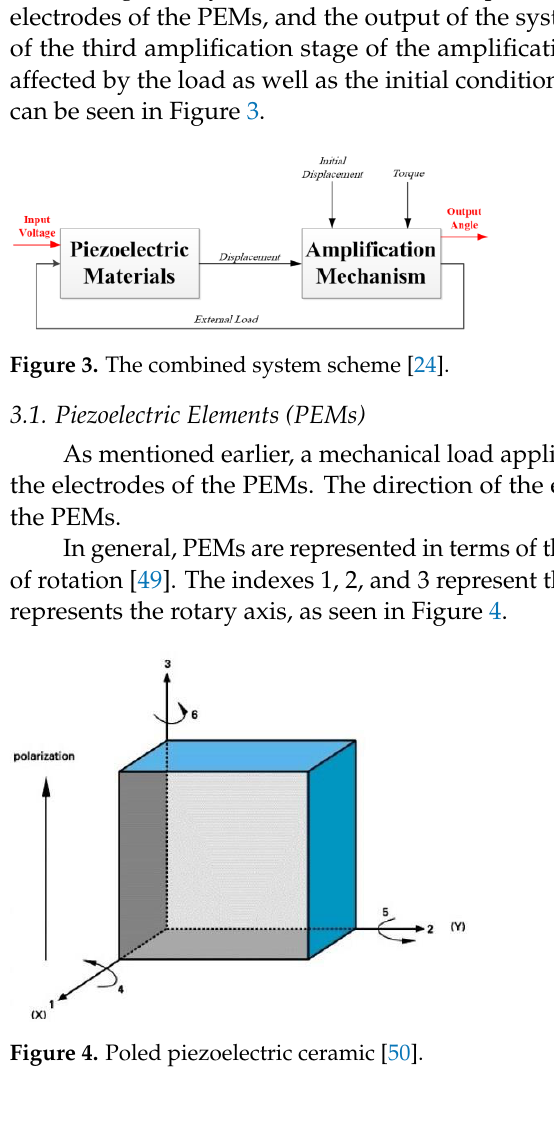
[meter] Table 2. Model parameters. Name